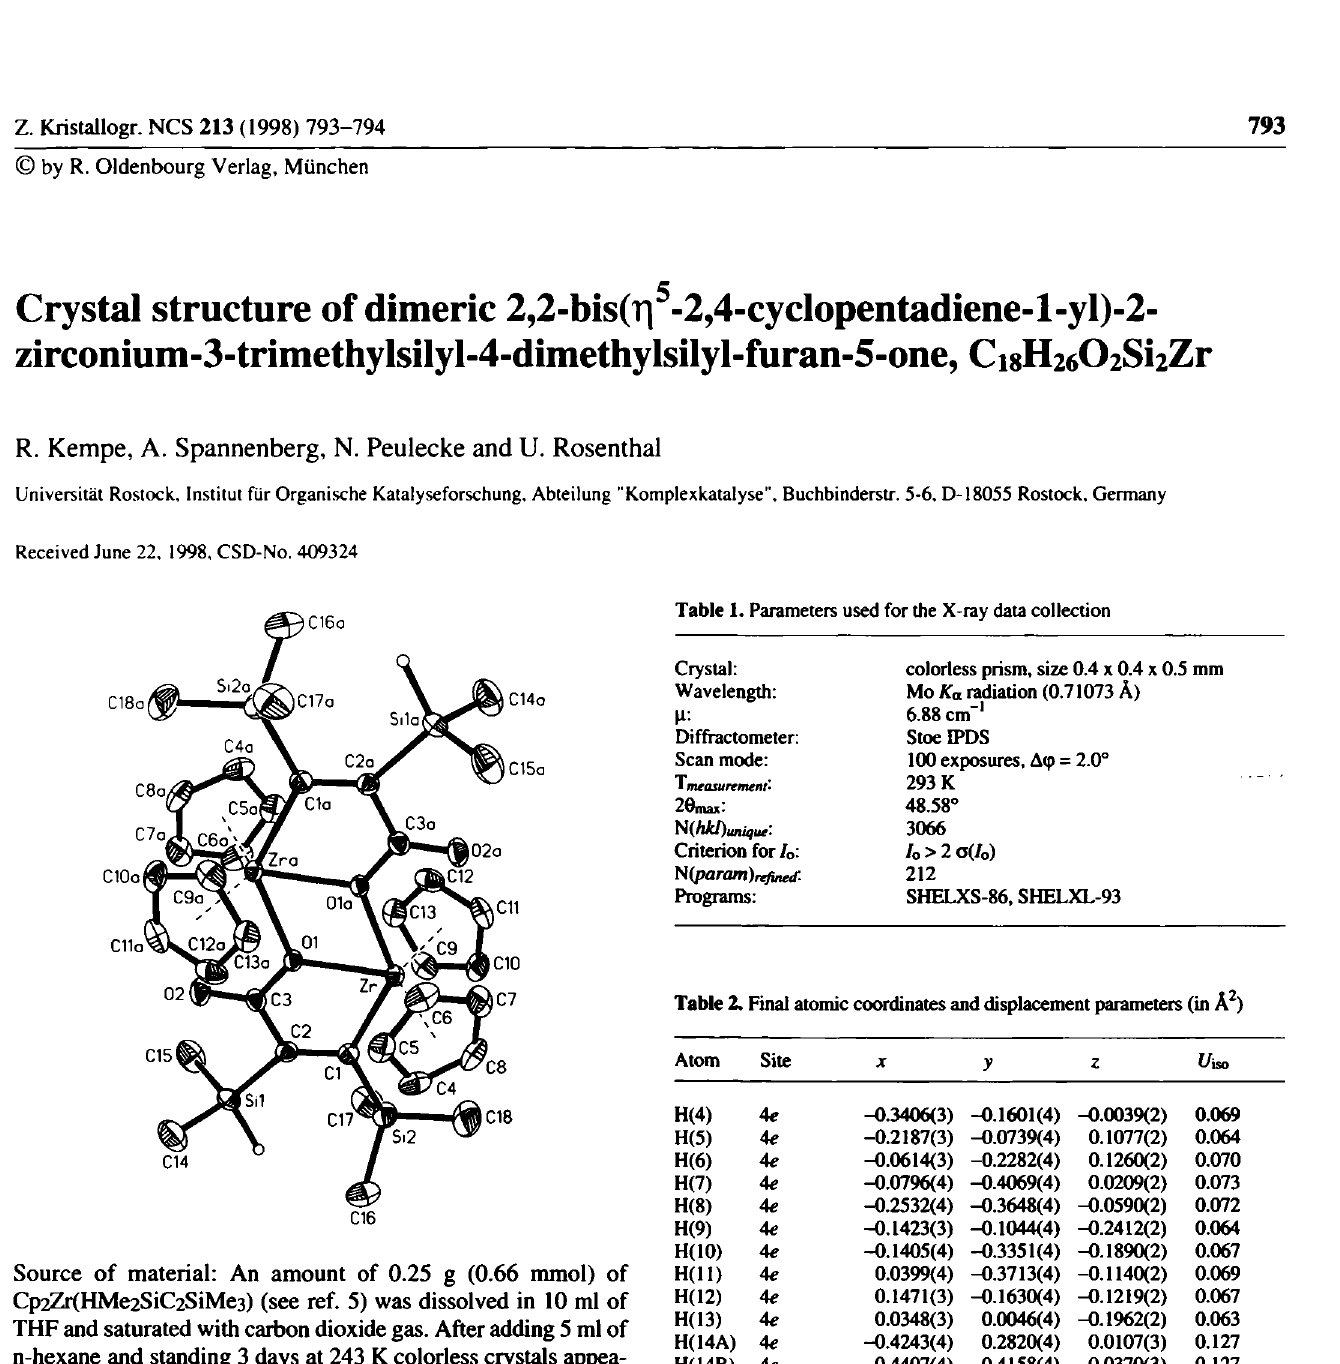
Table 2. Final atomic coordinates and displacement parameters (in